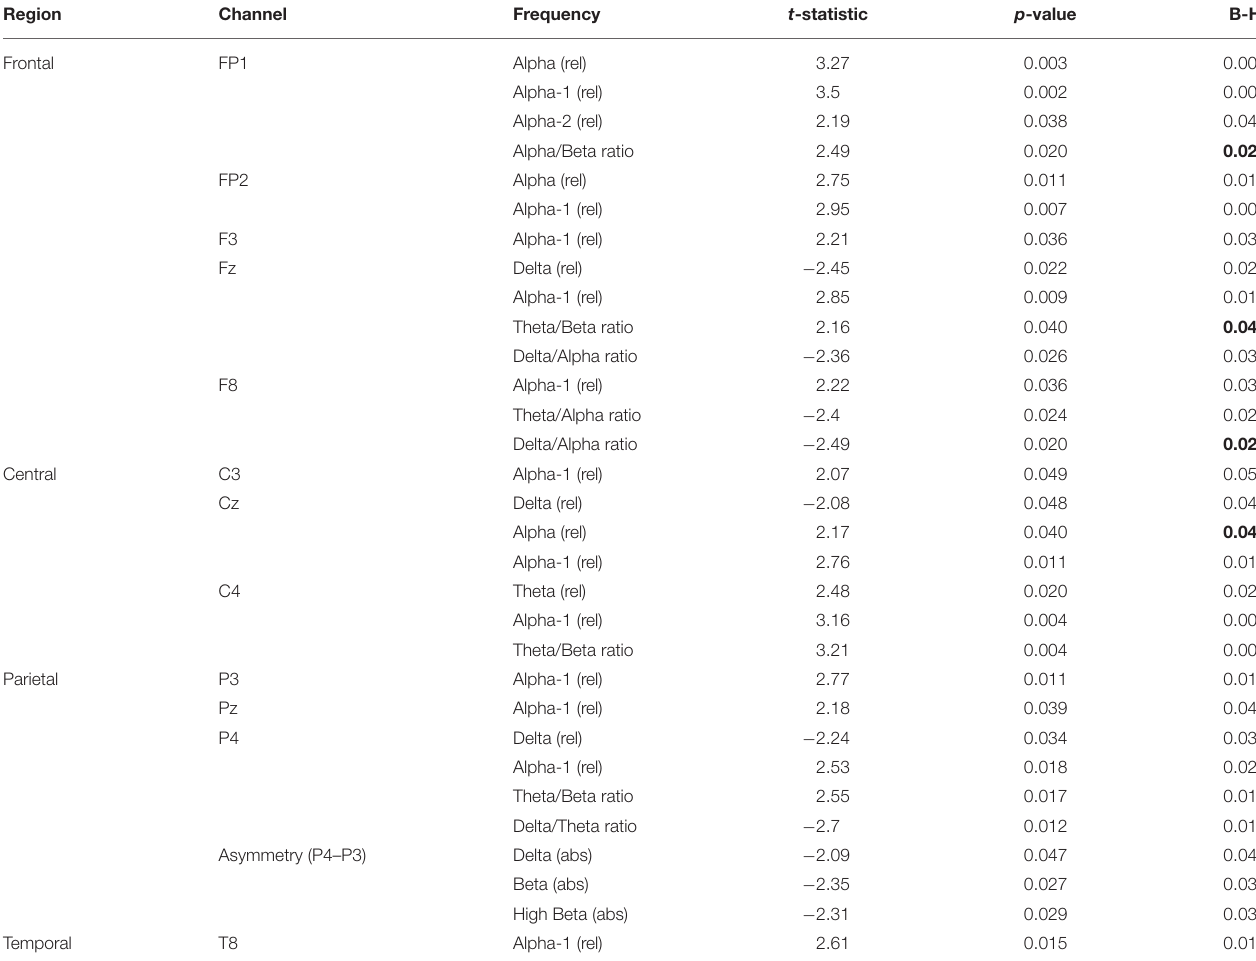
TABLE 2 | EEG variables with significant pre-post treatment difference.